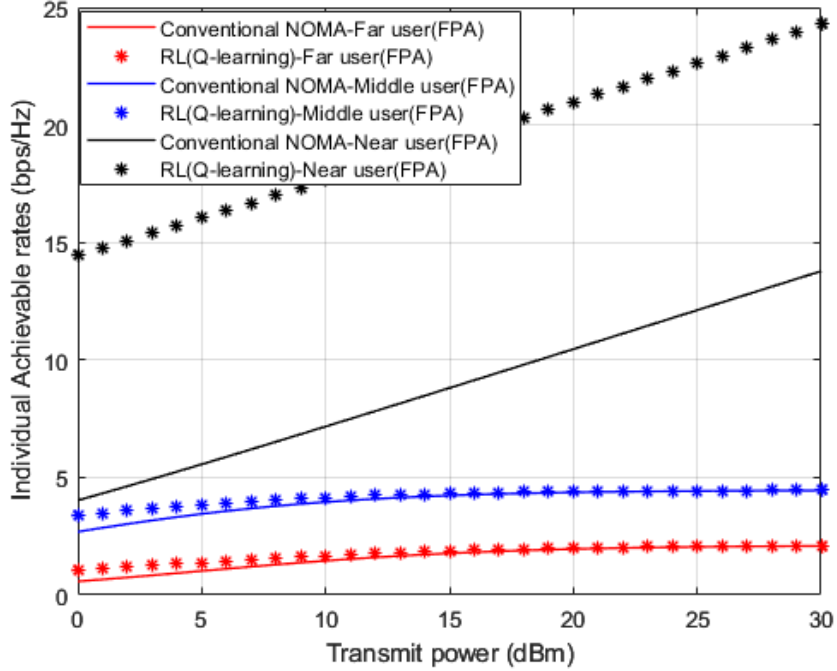
Figure 7. Sum rate vs. number of users (MMSE, LSTM, RL actor ‐ critic, RL Q ‐ learning).